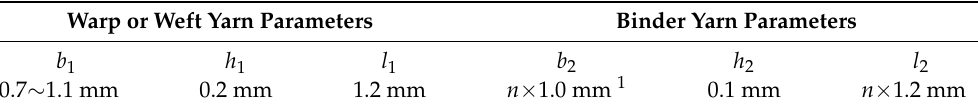
Table 12 lists the structural parameters of 3D-TCP used in the parameter analysis. Table 12. Structural parameters of 3D-TCP used in the parameter analysis. Warp or Weft Yarn Parameters